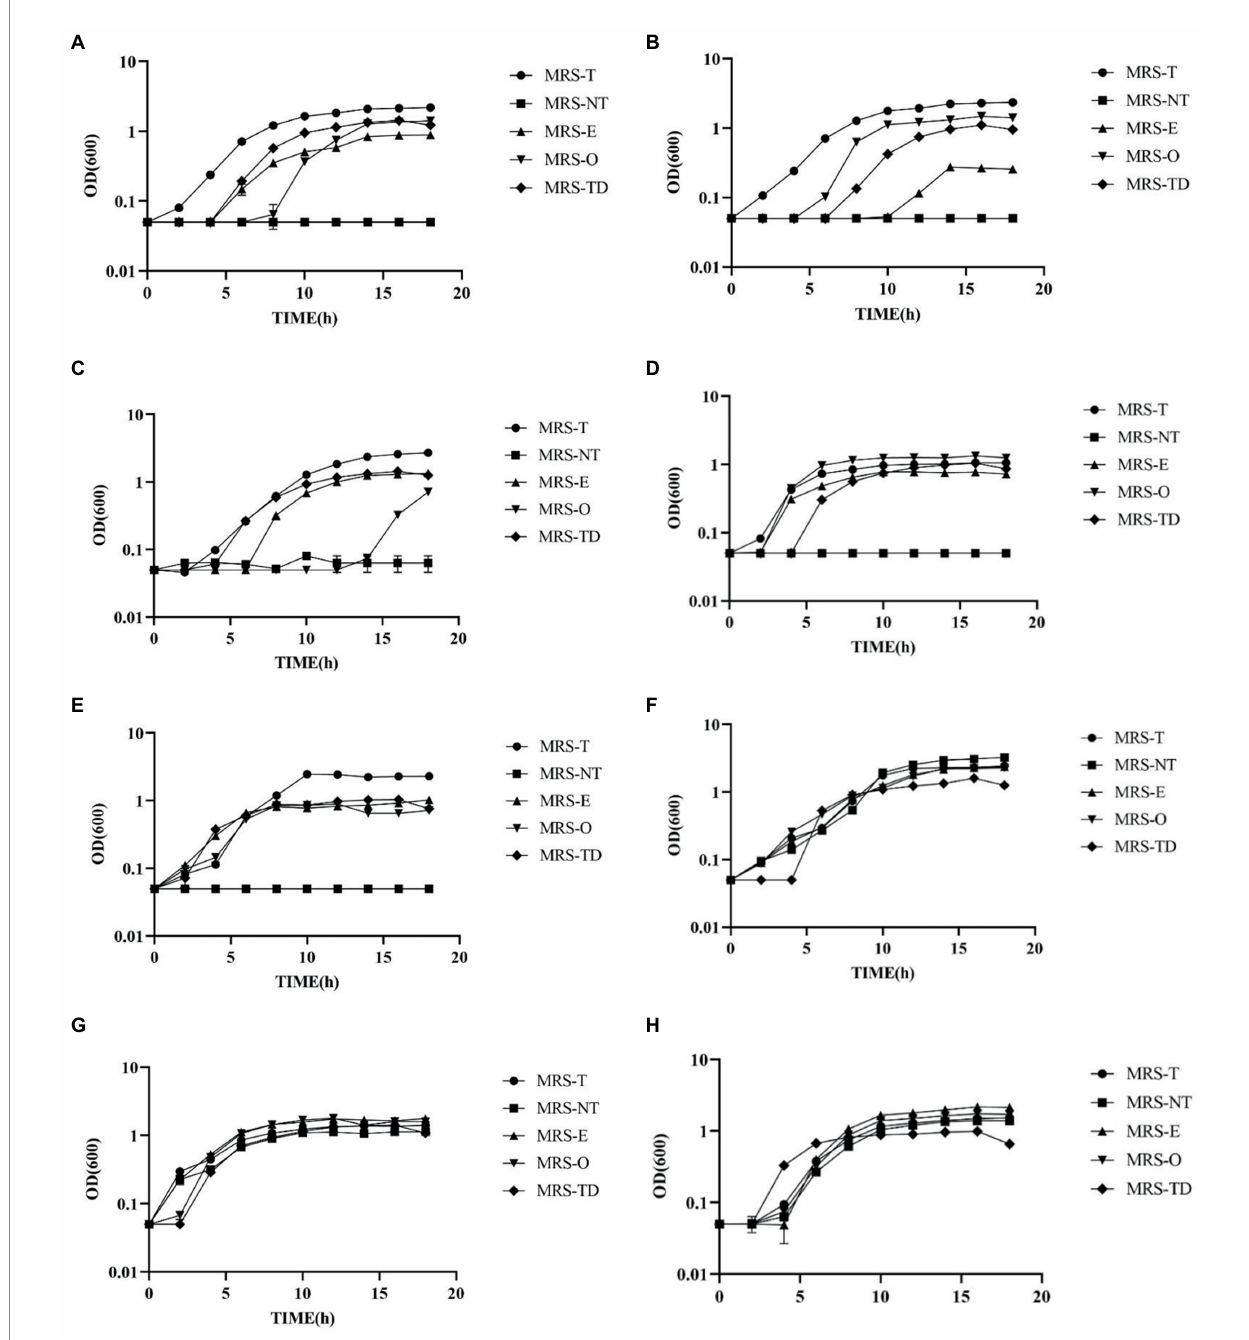
FIGURE 3 Lactobacillus species showed a visible ability to utilize erucic and oleic acid as a sole source of fatty acids. Growth curves of (A) Lactobacillus johnsonii N6.2, (B) L. johnsonii ATCC 33200, (C) Lactobacillus amylovorus ATCC 33620, (D) Ligilactobacillus murinus 35,020, (E) Limosilactobacillus reuteri TD1 (F) Ligilactobacillus fermentum 14,391 (G) Lactipantibacillus plantarum 25,302, and (H) Lacticaseibacillus casei ATCC 334, were grown in MRS-NT supplemented with 0.1% oleic acid (MRS-O), 0.1% erucic acid (MRS-E), Tween 80 (MRS-T), without Tween 80 (MRS-NT), and with Tween 80 and 0.1% DMSO